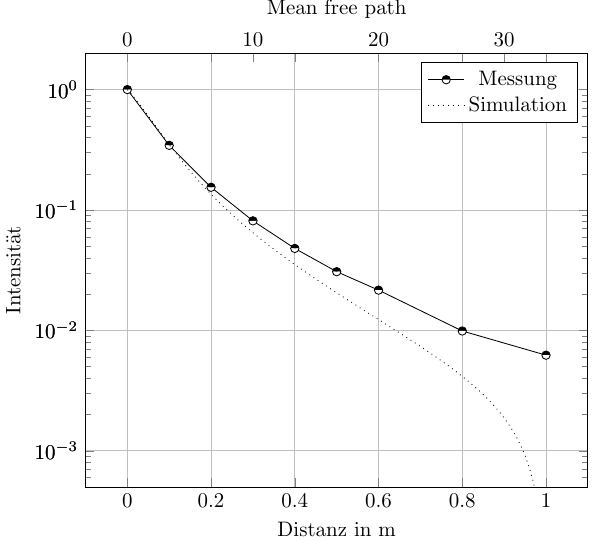
Figure 6. Comparison of simulated light intensity with experimental